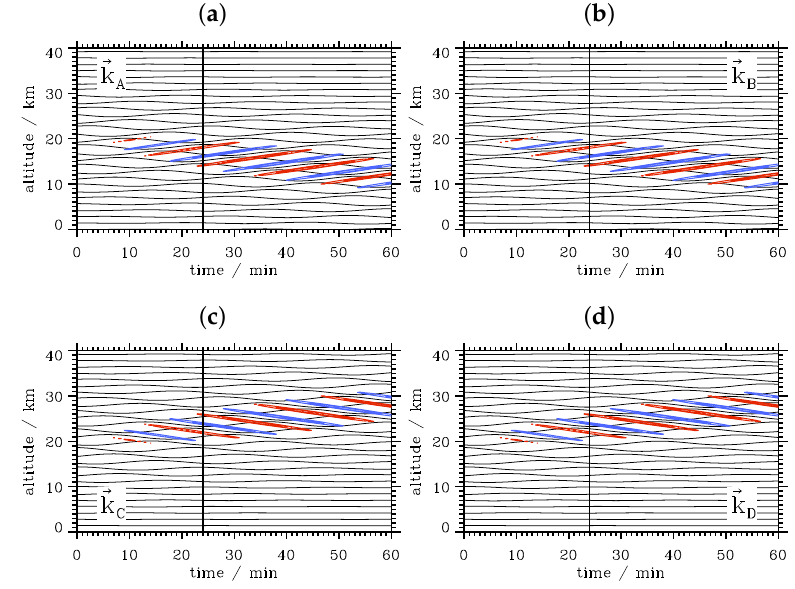
Figure 6. Vertical time series of the vertical displacements ξ ( x , z , t ) of horizontally- and vertically-propagating wave packets with four different wavenumber vectors (cid:126) k A ( a ), (cid:126) k B ( b ), (cid:126) k C ( c ) and (cid:126) k D ( d ) recorded at the positions marked in Figure 5, respectively. The wave packets are propagating downward ( c gz < 0) in the top row and upward ( c gz > 0) in the bottom row. Red and blue contour lines refer to ± 0.95 times the wave amplitude and illustrate phase lines. The vertical black lines refer to the time when the plots shown in Figure 5 are